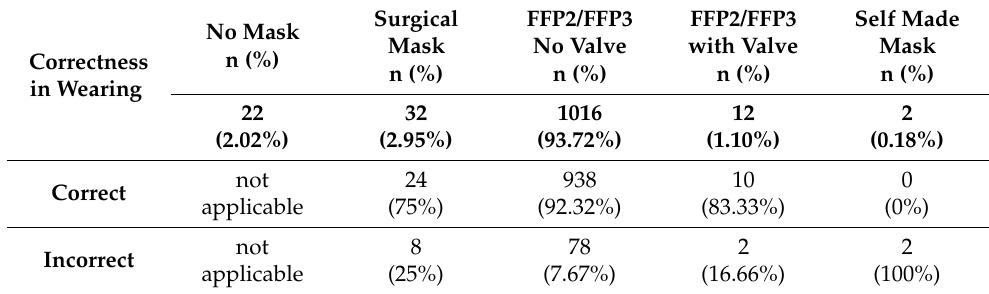
Table 1. Distribution of result about wearing.